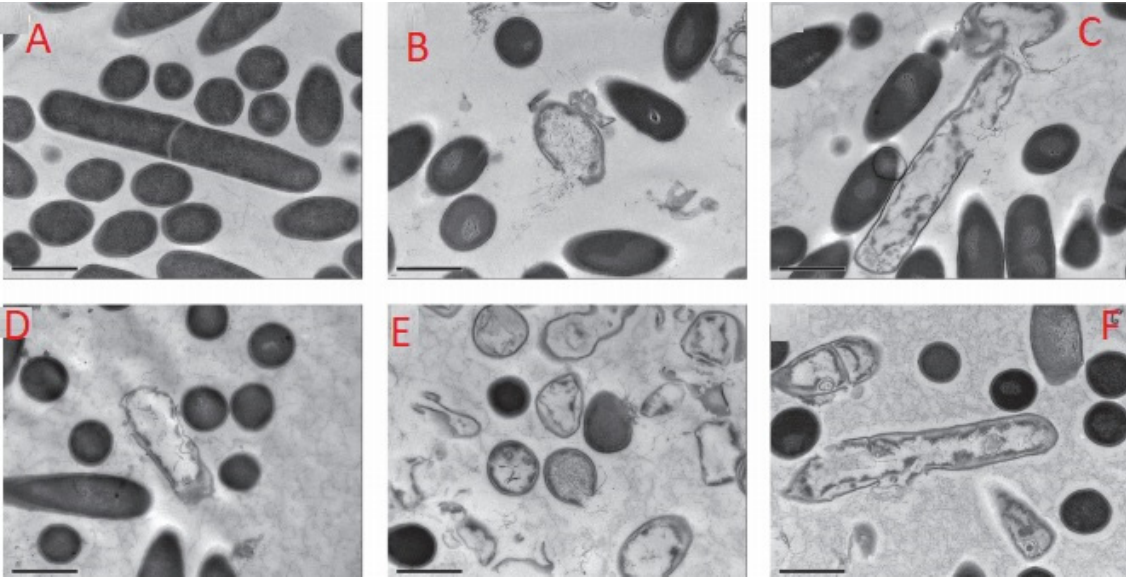
Figure 2. Transmission electron micrographs of C. difficile ATCC 630 grown in brain heart infusion (BHI) broth and treated in suspension (10 6 c.f.u.) for 1 min with ( A ) no inhibitor, ( B ) nisin A (16 μ g/mL), ( C ) nisin Z (64 μ g/mL), ( D ) vancomycin (5 μ g/mL), ( E ) nisin A (32 μ g/mL) and ( F ) nisin Z (128 μ g/mL) [54].